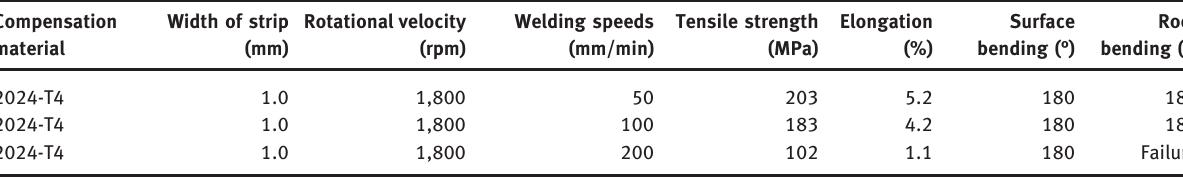
Table 2: Mechanical properties of VCFSW of 6061-T6 aluminum alloy.